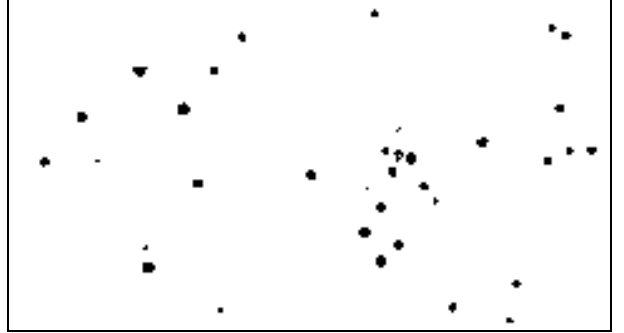
Figure 10. Combined star mask, showing the exclusion zones for avoiding false positives.